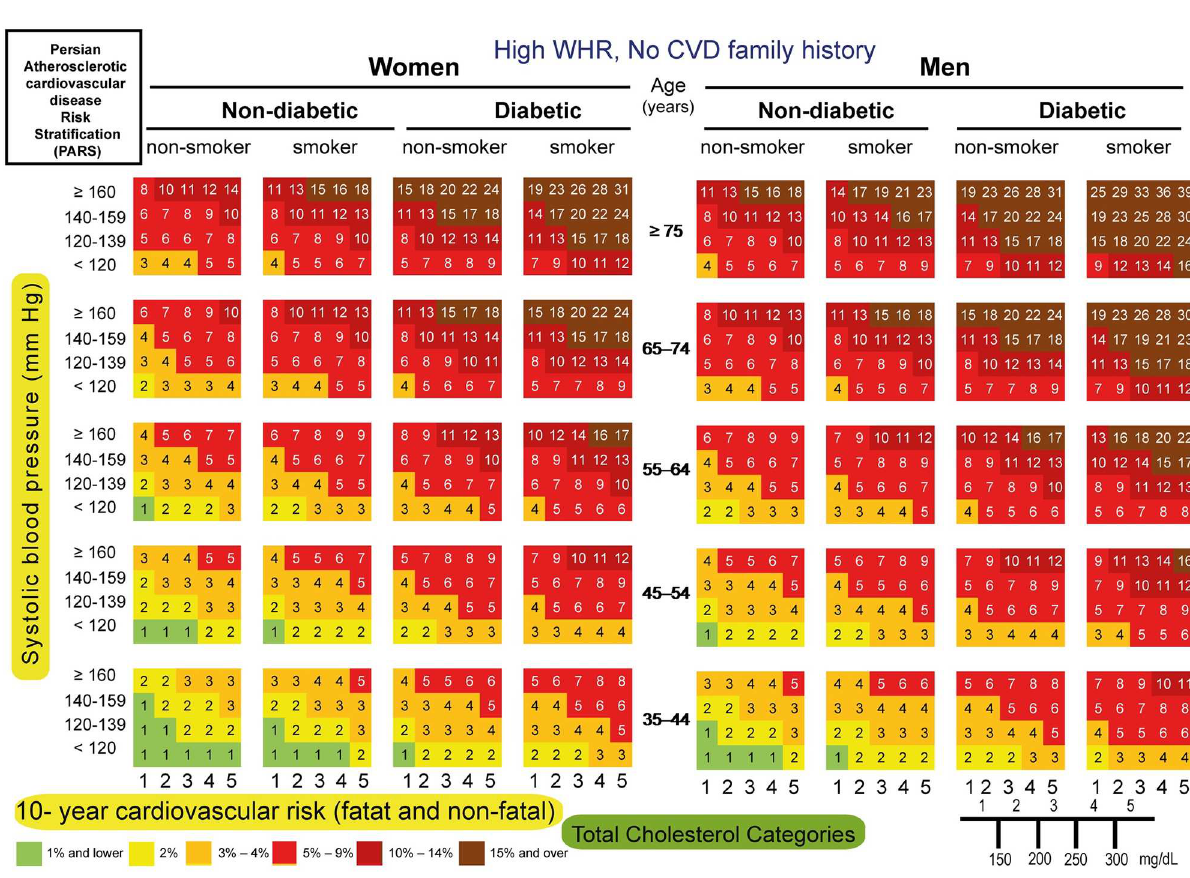
Fig 4. PARS charts for prediction of 10-year risk of fatal and non-fatal cardiovasculardisease in ICS population with higher WHR and no CVD family history, 2001–2011.